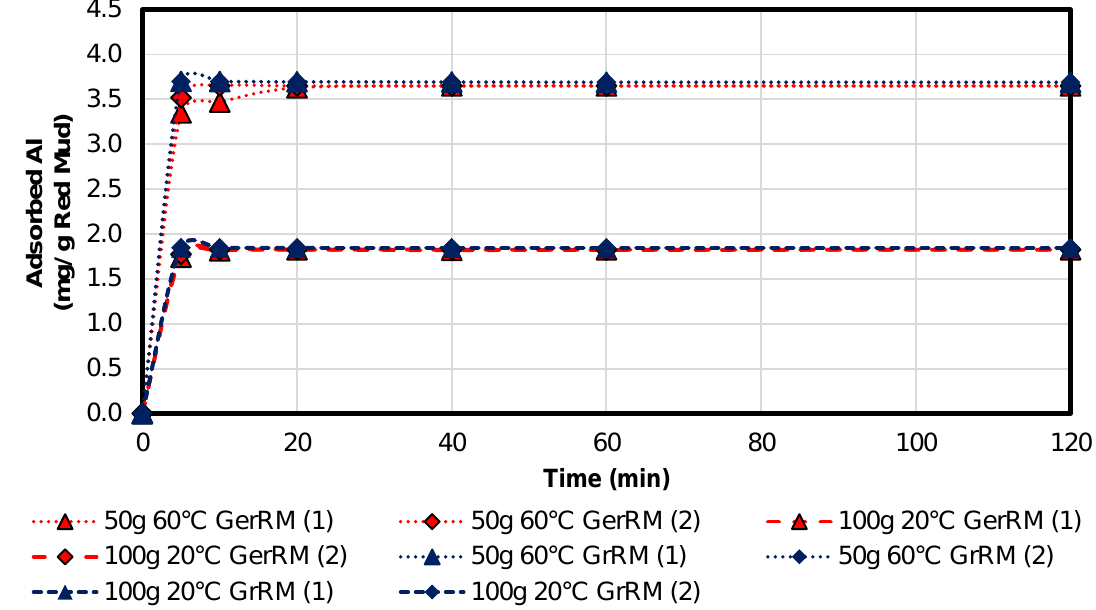
Figure 11. Kinetics of aluminium adsorption for both red muds [mg/g].